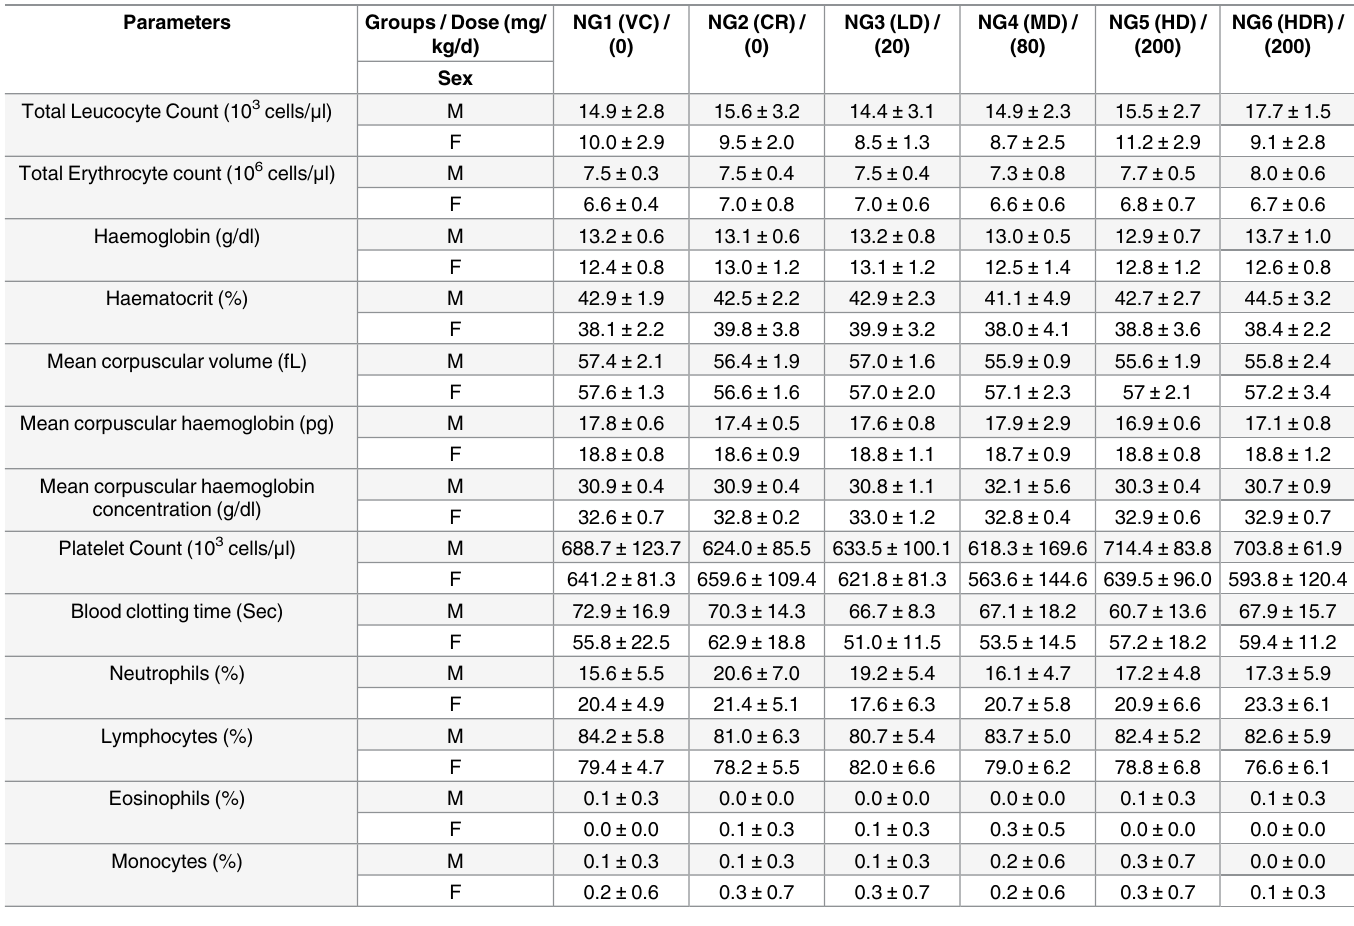
Table 3. Effect of 90 day oral administration of 3’-HPT on haematology data of male and female SD rats.